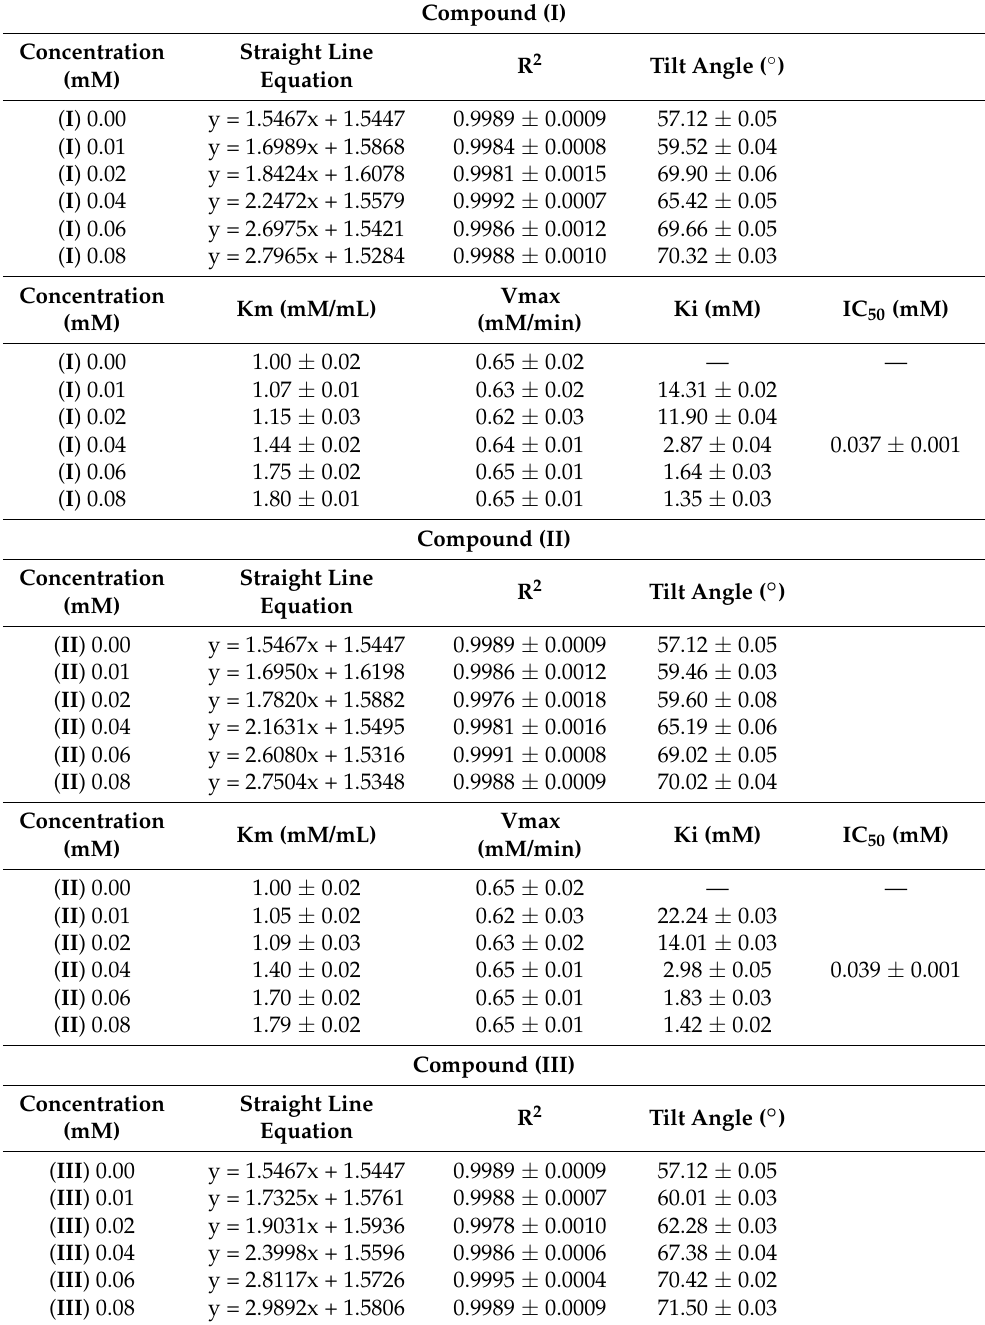
Table 2. The analytical data describing effects of acetylcholinesterase inhibition by aminoalkanol derivatives ( I ), ( II ), ( III ) and ( IV ) and regression equation for acetylthiocholine for 6 replicates for each sample ( n = 6) at the concentration range 0.36–46.00 mM, in the presence of inhibitors ( I ), ( II ), ( III ) and ( IV ), at a concentration of 0.01, 0.02, 0.04, 0.06 and 0.08